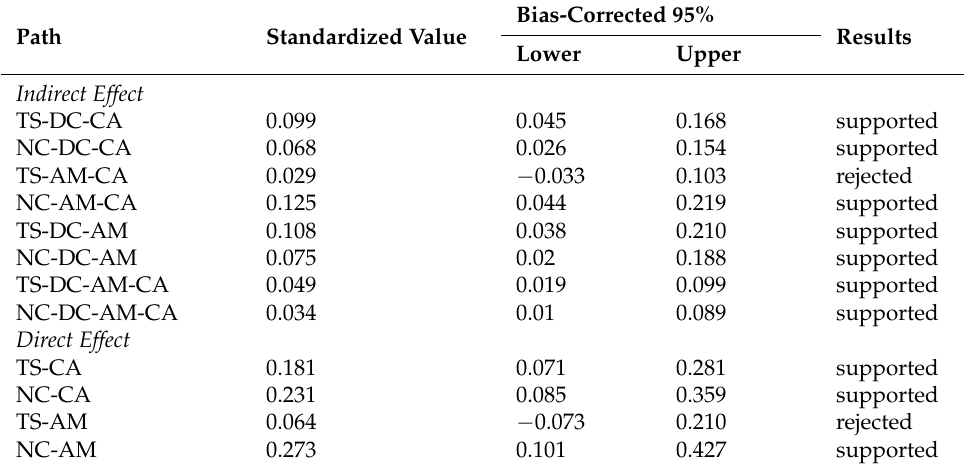
Table 3. Bootstrap test of direct effect and indirect